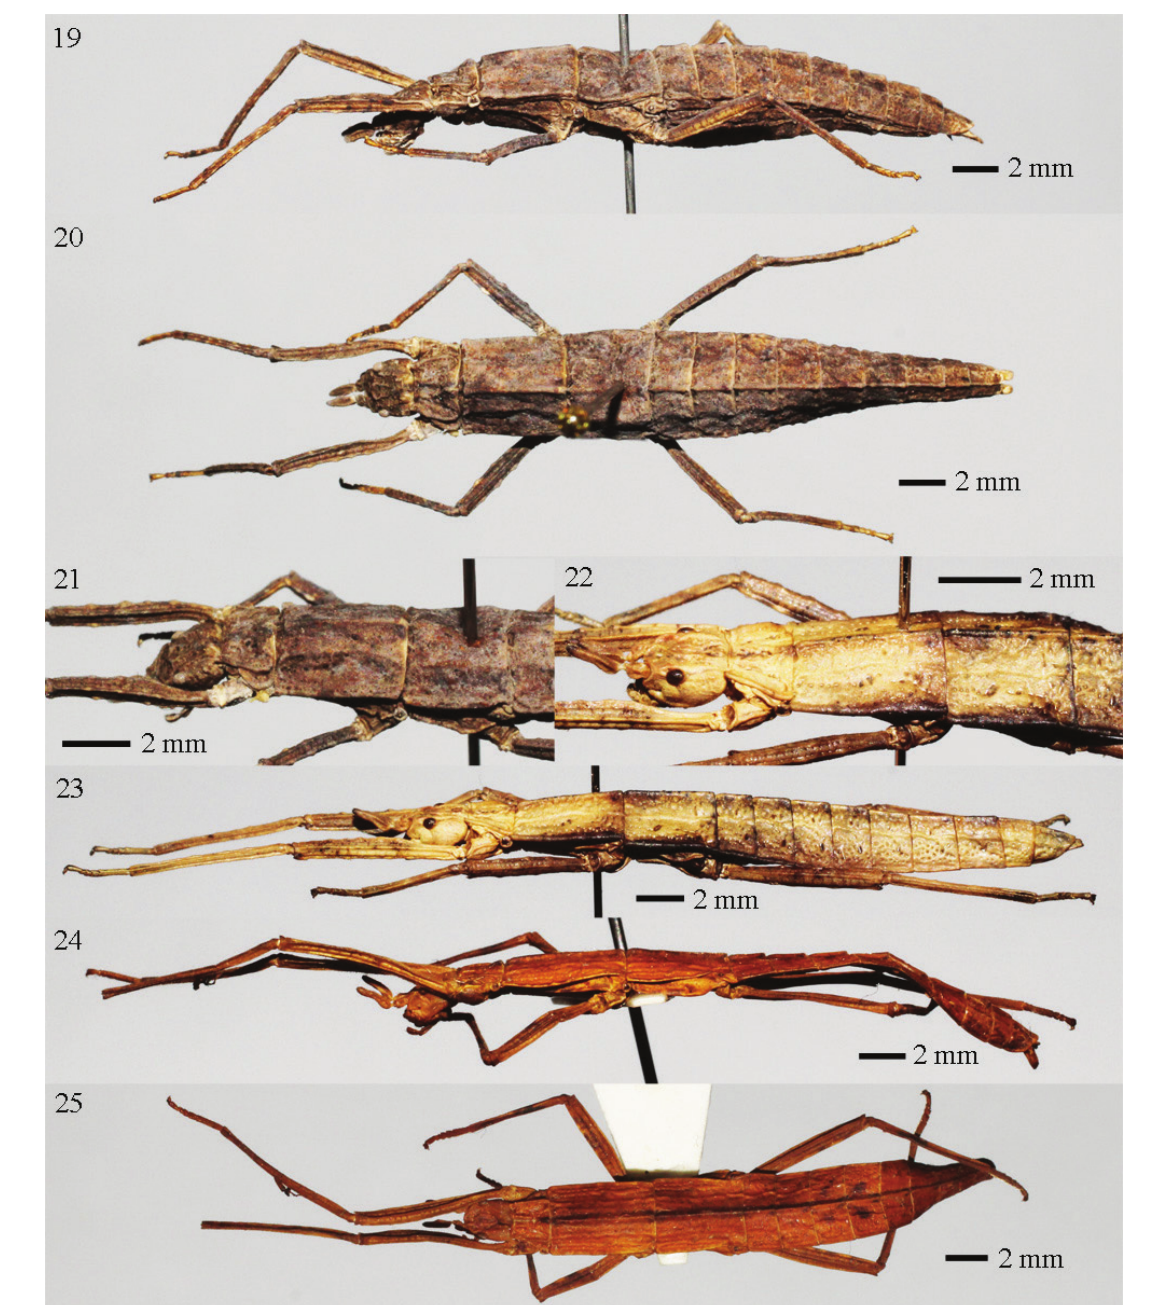
Figs 19–25. Paragongylopus ( Planoparagongylopus ) subgen. n. spp. 19. P . ( Planoparagongylopus ) abramovi sp. n.: ♀ , habitus, lateral view; 20. P . ( Planoparagongylopus ) abramovi sp. n.: ♀ , habitus, dorsal view; 21. P . ( Planoparagongylopus ) abramovi sp. n.: ♀ , head and thorax, dorsolateral view; 22. P . ( Planoparagongylopus ) lii sp. n.: ♀ , head and thorax, dorsolateral view; 23. P . ( Planoparagongylopus ) lii sp. n.: ♀ , habitus, lateral view; 24. P . ( Planoparagongylopus ) nabanheensis sp. n.: ♀ , habitus, lateral view; 25. P . ( Planoparagongylopus ) nabanheensis sp. n.: ♀ , habitus, dorsal